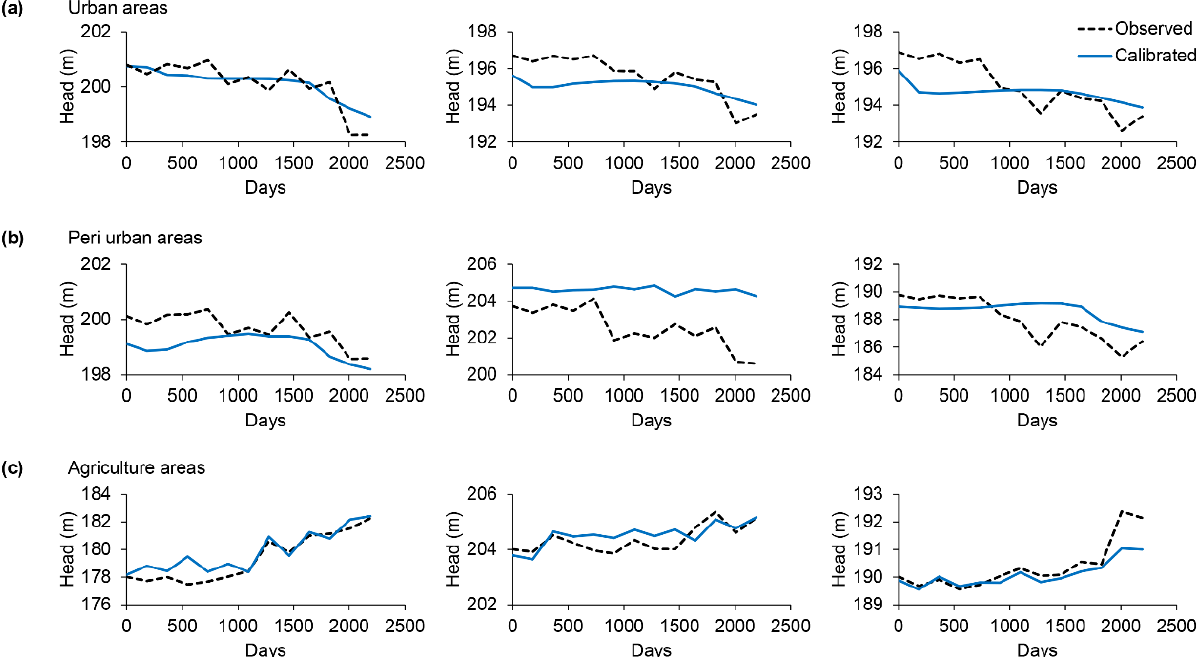
Figure 8. Calibration results of a transient GMS-MODFLOW model for groundwater levels in Lahore across ( a ) urban areas, ( b ) peri urban areas, and ( c ) agriculture areas. Note: Peri-urban areas are referred to as areas situated on the outskirts of urban areas and comprise mixed and fragmented landscapes of rural and urban areas [72].